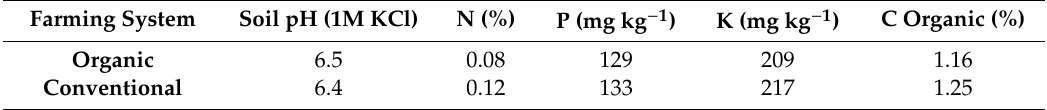
Table 1. Soil characteristics before the establishment of the experiment (2016).